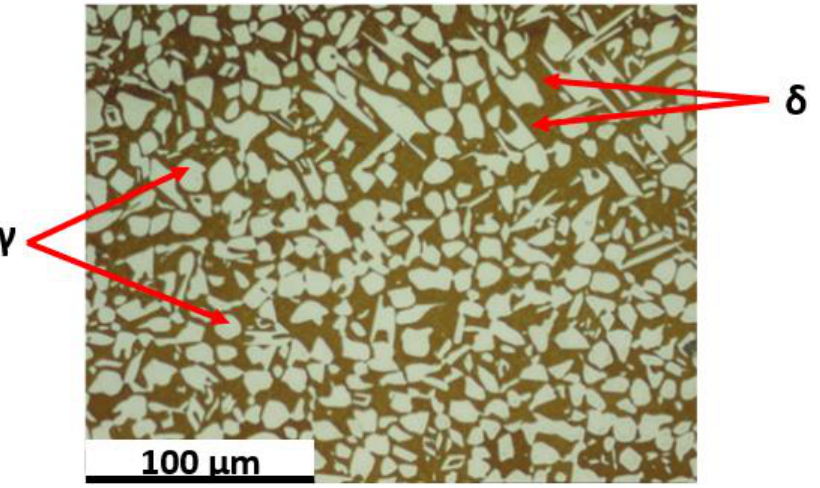
Figure 8. Equiaxed microstructure of superduplex stainless steel. Ferrite grains appear in dark and austenite ones appear in light.